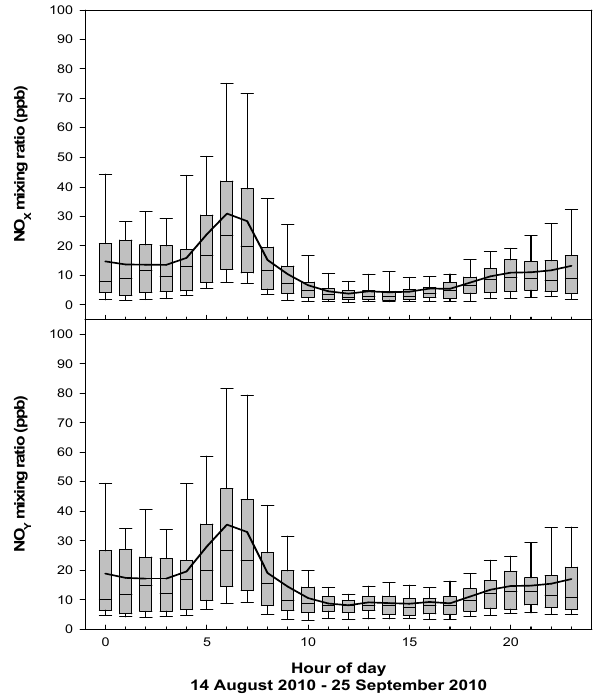
Fig. 7. Diurnal profiles of NO X and NO Y mixing ratios during the summer of 2010 at the Moody Tower.